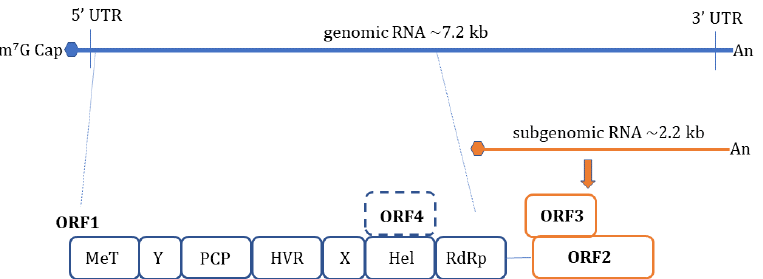
Figure 1. Schematic illustration of Hepatitis E virus (HEV) genome organization. The HEV genome is a single-stranded positive-sense RNA of ~7.2 kb in length. It has a 7- methylguanosine (m7G) cap at the 5 ′ end and a poly-A tail at the 3 ′ end. The coding region is flanked by 5 ′ - and 3 ′ - UTRs (Untranslated regions), respectively. The largest open reading frame, ORF1, has several predicted domains, including methyltransferase (MeT), Y domain (Y), papain-like cysteine protease (PCP), hypervariable region (HVR), X domain (X), helicase (Hel), and RNA-dependent RNA polymerase (RdRp). ORF2 and ORF3 are encoded by a subgenomic RNA of ~2.2 kb. ORF2 is the capsid protein. ORF3 partially overlaps with ORF2. The novel ORF4 which is overlapped with ORF1 is only identified in genotype 1.